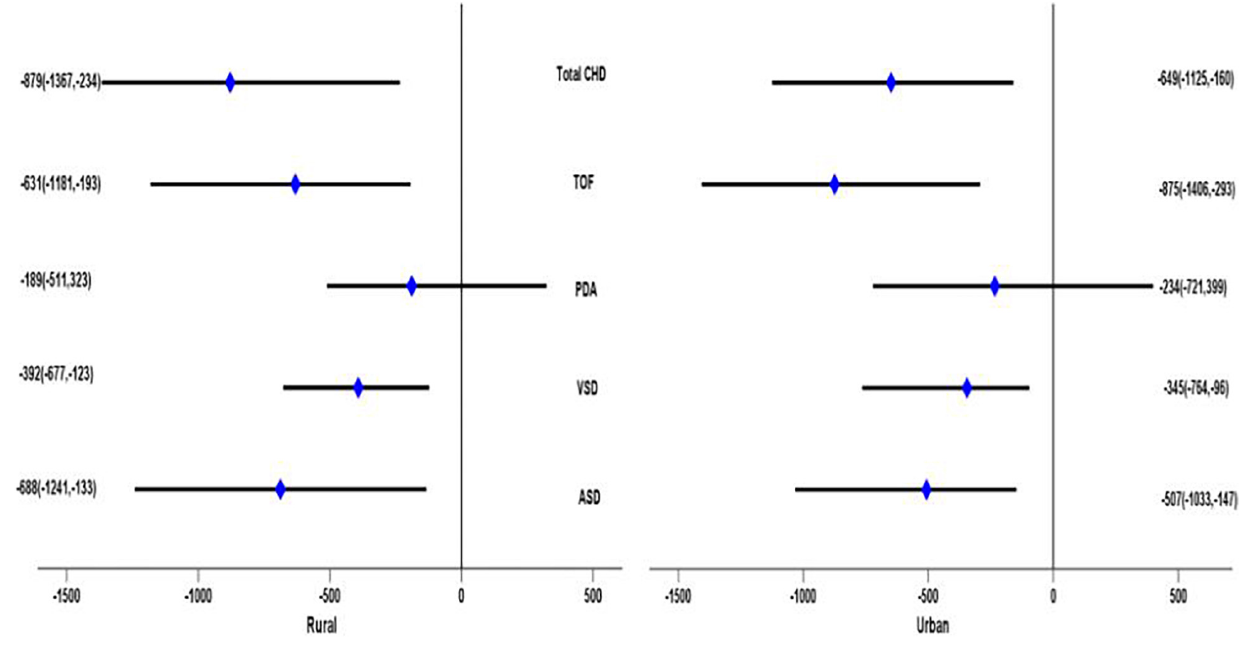
Frontiers in Pediatrics |